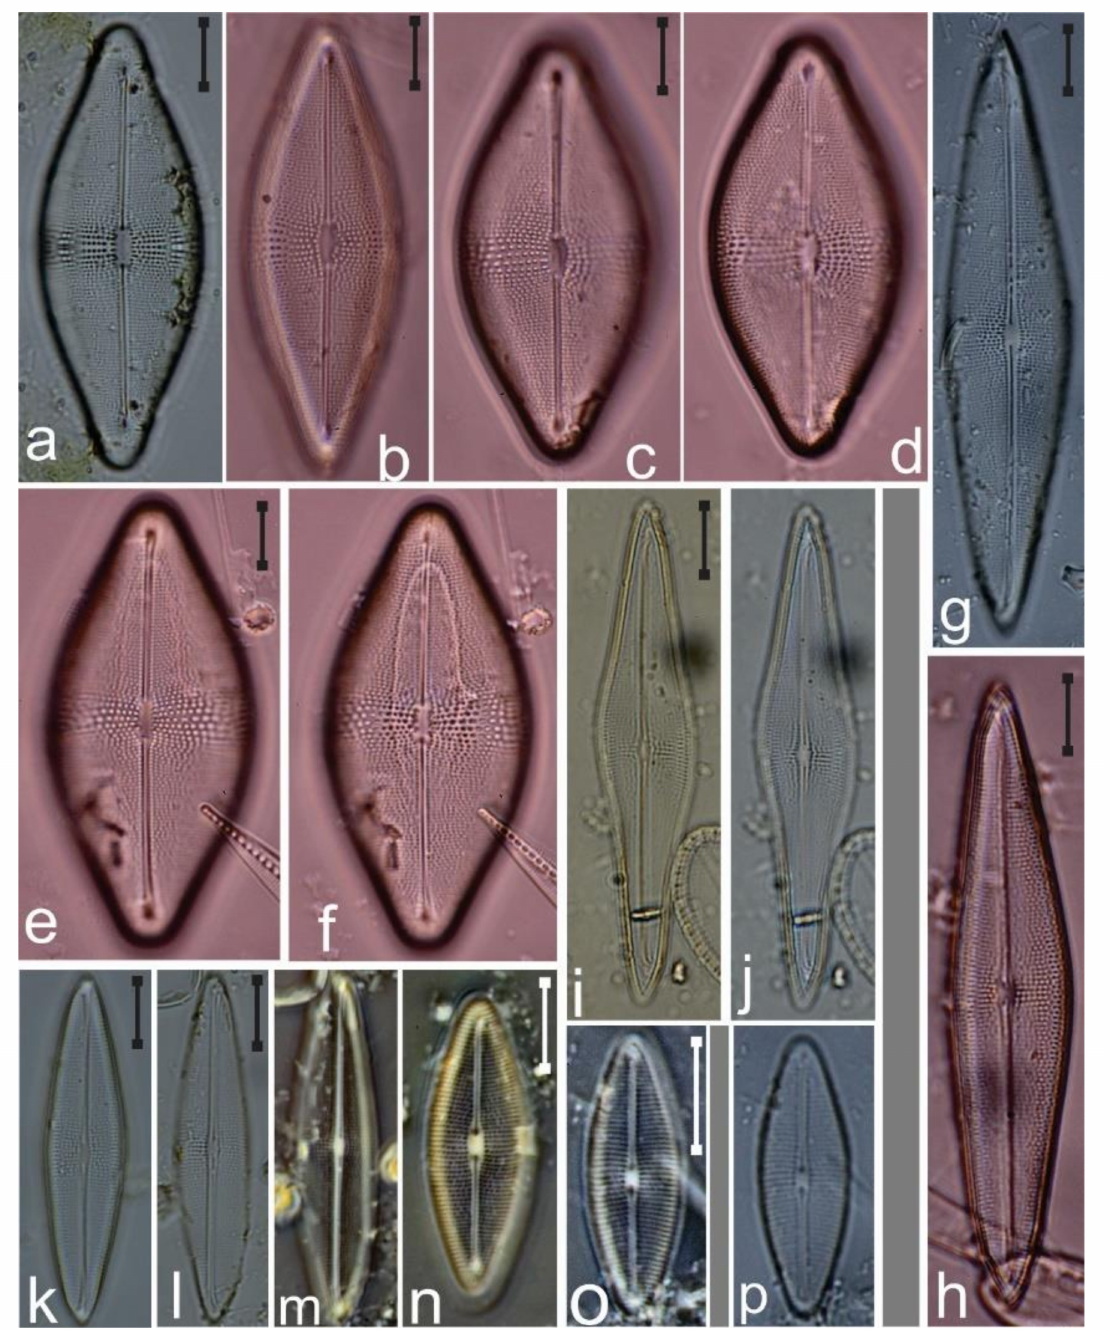
Figure 30. ( a – f ) Parlibellus weissflogii ; ( g , h , k – m ) P. rhombicula ; ( i , j ) P. rhombicus ; ( n – p ) P. delognei . Scale bar = 10 µ